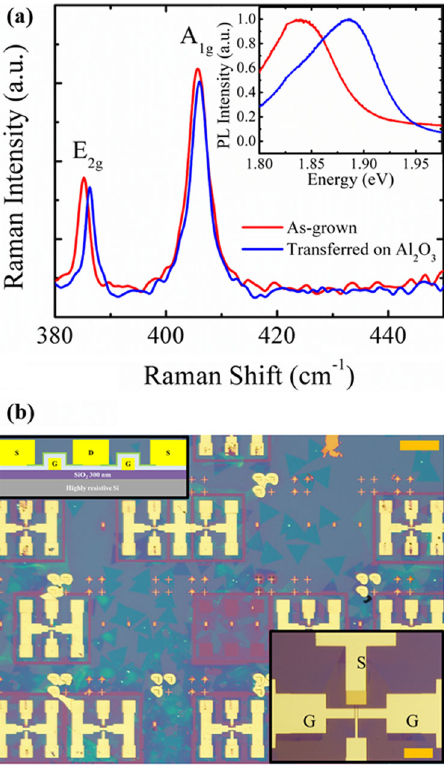
Fig. 1 Material characterization and optical image a Raman and photoluminescence (inset) spectra before and after transfer con fi rming the preserved CVD MoS 2 quality. The slight shift in the in-plane vibrational mode, E 2g , and the blue shift in the photo- luminescence peak correspond to a release of thermal mismatch induced strain. b Optical image of a CVD MoS 2 device array with close-up gate fi nger layout ( bottom-right inset) and a cross-sectional schematic of an embedded gate MoS 2 FET ( top-left inset). The scale bar for the array ( top-right ) is 150 µm and the scale bar for the inset ( bottom-right ) is 10 µm MoS 2 -dielectric interface with less fi xed-charge and organic impurities. 13 As a result, the threshold voltage, V th , is positive and close to 0 V, in contrast to many top-gated structures, which suffer from uncompensated charge at the surface. 7 As shown in Fig. 2b, we measure a transconductance, g m , of 70 µS/µm at a V ds = 2.5 V. This is among the highest reported g m for MoS 2 FETs on exfoliated or CVD grown fi lms, at equivalent electric fi elds. 5, 7 The maximum fi eld-effect mobility, µ FE , is 21.2 cm 2 /Vs, and after contact resistance correction is 81.6 cm 2 /Vs. 15 In addition to the improved MoS 2 -dielectric interface, the embedded gate structure provides improved gate control over the channel. After transfer, the MoS 2 wraps conformally to the rectangular gate fi ngers. The electrostatic control is improved over top-gated devices because the electric fi eld fl ux reaching the MoS 2 channel is increased at an equivalent gate voltage. As an enhancement mode device, we can suf fi ciently deplete the channel to achieve an I ON / I OFF ratio of 10 8 . Figure 2c shows the I ds − V ds output characteristics for the same device. The device achieves current densities of 120 µA/µm at V ds = 3.5 V. There is clear current saturation beyond V ds of 3 V, resulting in a drain conductance, g ds , within 5 µS/µm in the current saturation region (3 to 3.5 V of V ds ). The sub-linear curves at low V ds indicate a signi fi cant Schottky barrier. We attribute this to undoped contacts and access regions. Our previous top-gated CVD MoS 2 RF FETs [7] employed sub-stoichiometric HfO 1.56 which extrinsically doped the MoS 2 contacts and access regions. This n -doping helped reduce the contact/access resistance due to